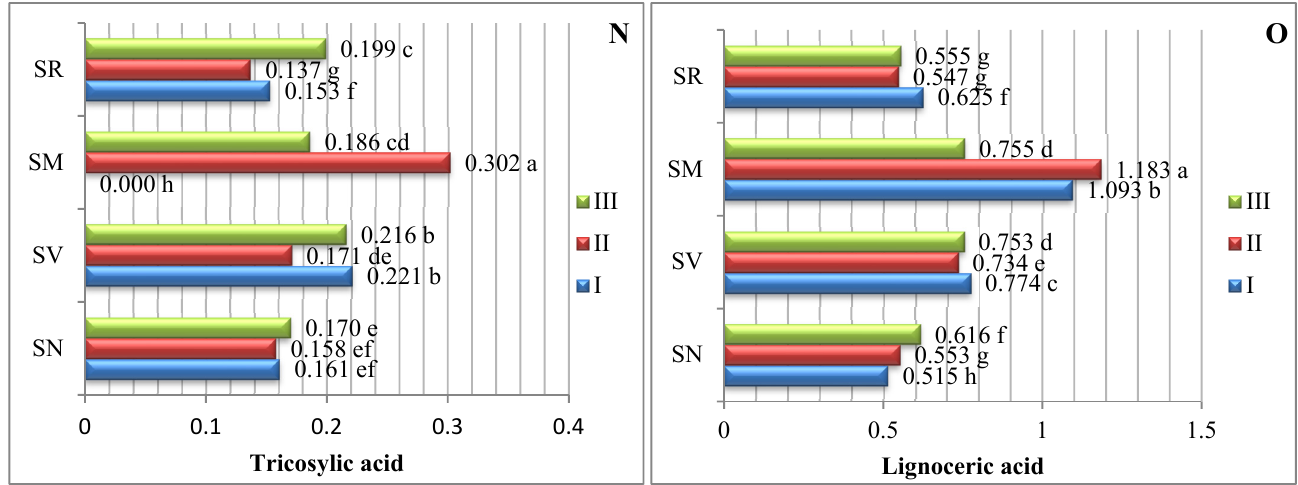
Figure 1. Amounts of saturated fatty acids in Solanum spp. fruit, %, in different ripening stages. Note: Percentages followed by different letters are statistically different ( p < 0.05); S. retroflexum –